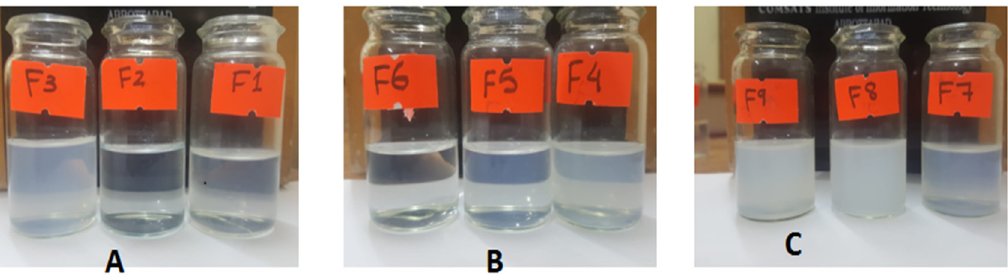
Figure 5. Set of nanoemulsions developed with Glycerin ( A ), Polyethylene glycol ( B ) and Propylene glycol ( C ) as solvents.